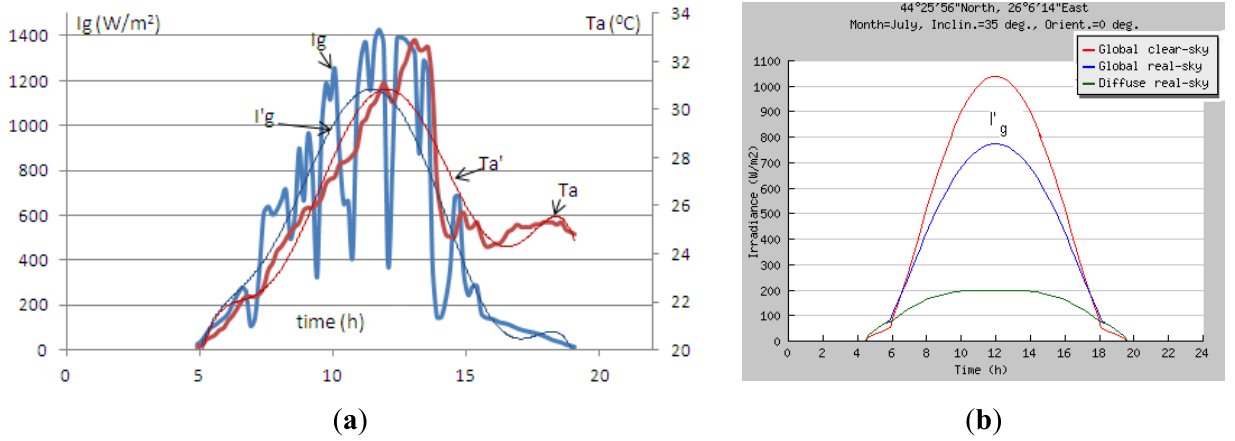
Figure 2. Global solar irradiance on a tilted plane for a partly cloudy sky day from July, 2009: ( a ) Proprietary software, T ’ polynomials; ( b ) JRC PVGIS application.